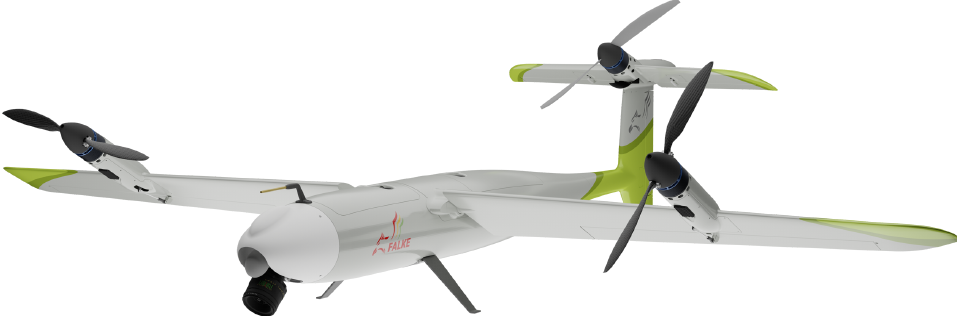
Figure 5. 3D rendering of the “Neo” tilt-wing UAS by flyXdrive used in the